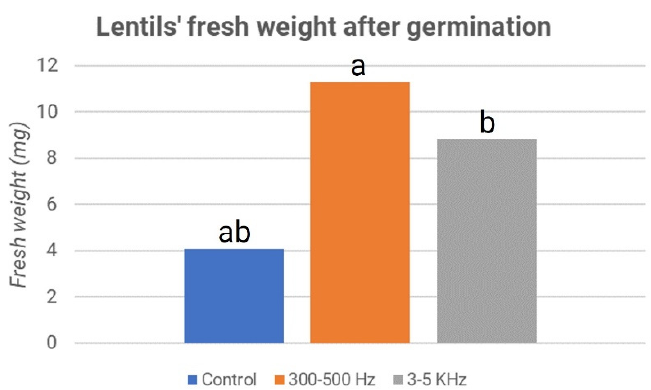
Figure 8. Lentils’ fresh weight after germination: second experiment. The letters “a” and “b” refer to the statistical significance of the observed difference between sample couples with a p -value < 0.05 and n = 196.